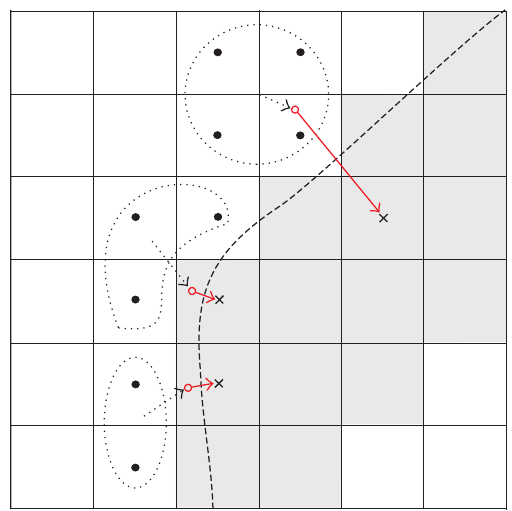
Figure 5: Interpolation from interior cells to construct mirrored values to be used within internal ghost cells